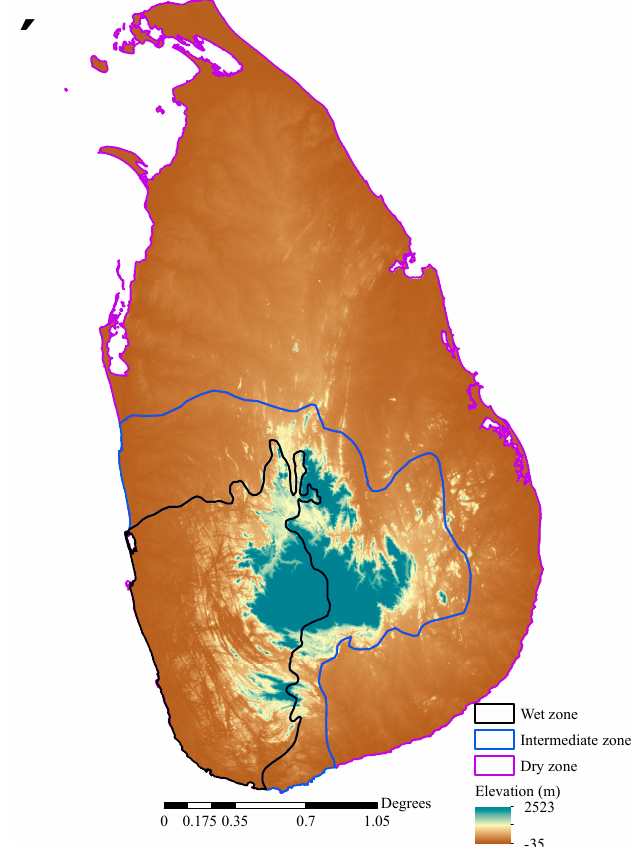
Figure 1. Topography and climatic zones of Sri Lanka.